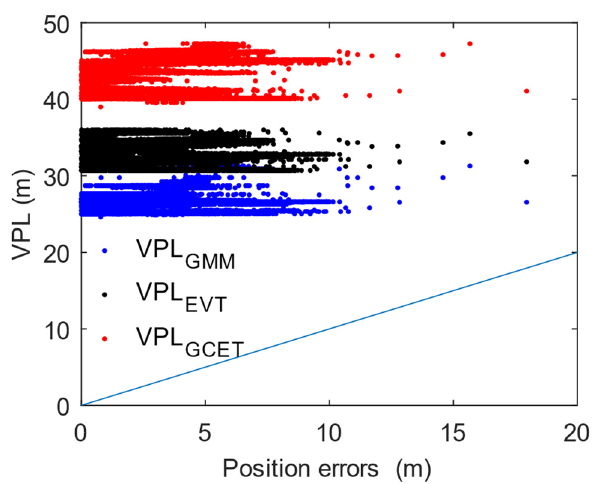
Figure 8. Actual VPLs produced by the different overbounds against the observed errors on 25 January 2021.